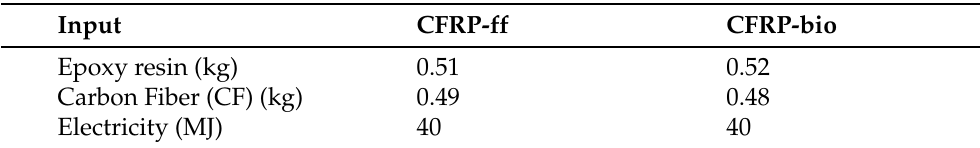
Table 5. Impregration of the CF with the epoxy resin. Data refer to 1 kg of prepreg. Data on energy consumption were taken from Song et al.